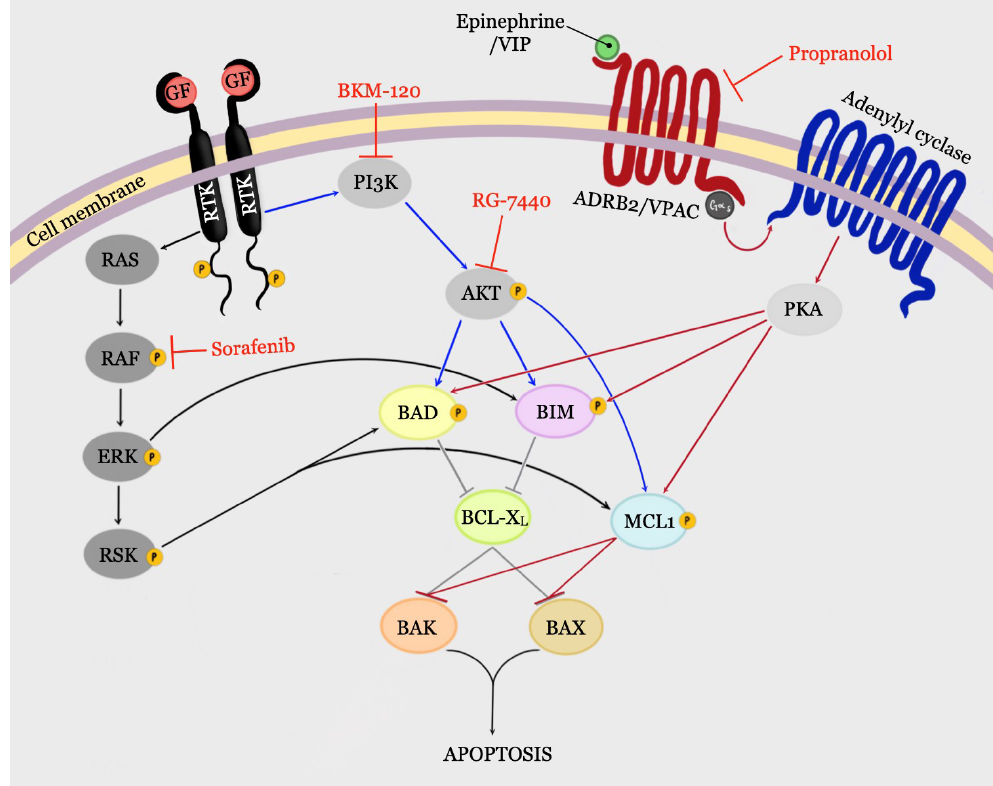
Figure 2. Apoptosis regulatory network in prostate cancer. MCL1 and BCLXL are dominant anti-apoptotic BCL2-family proteins in prostate cancer cells. RTK/ERK, PI3K/AKT and ADRB2/PKA signaling regulates transcription, translation and degradation of the anti-apoptotic protein MCL1 and pro-apoptotic functions of BIM and BAD. Inhibitors of these pathways are being tested in clinical trials.